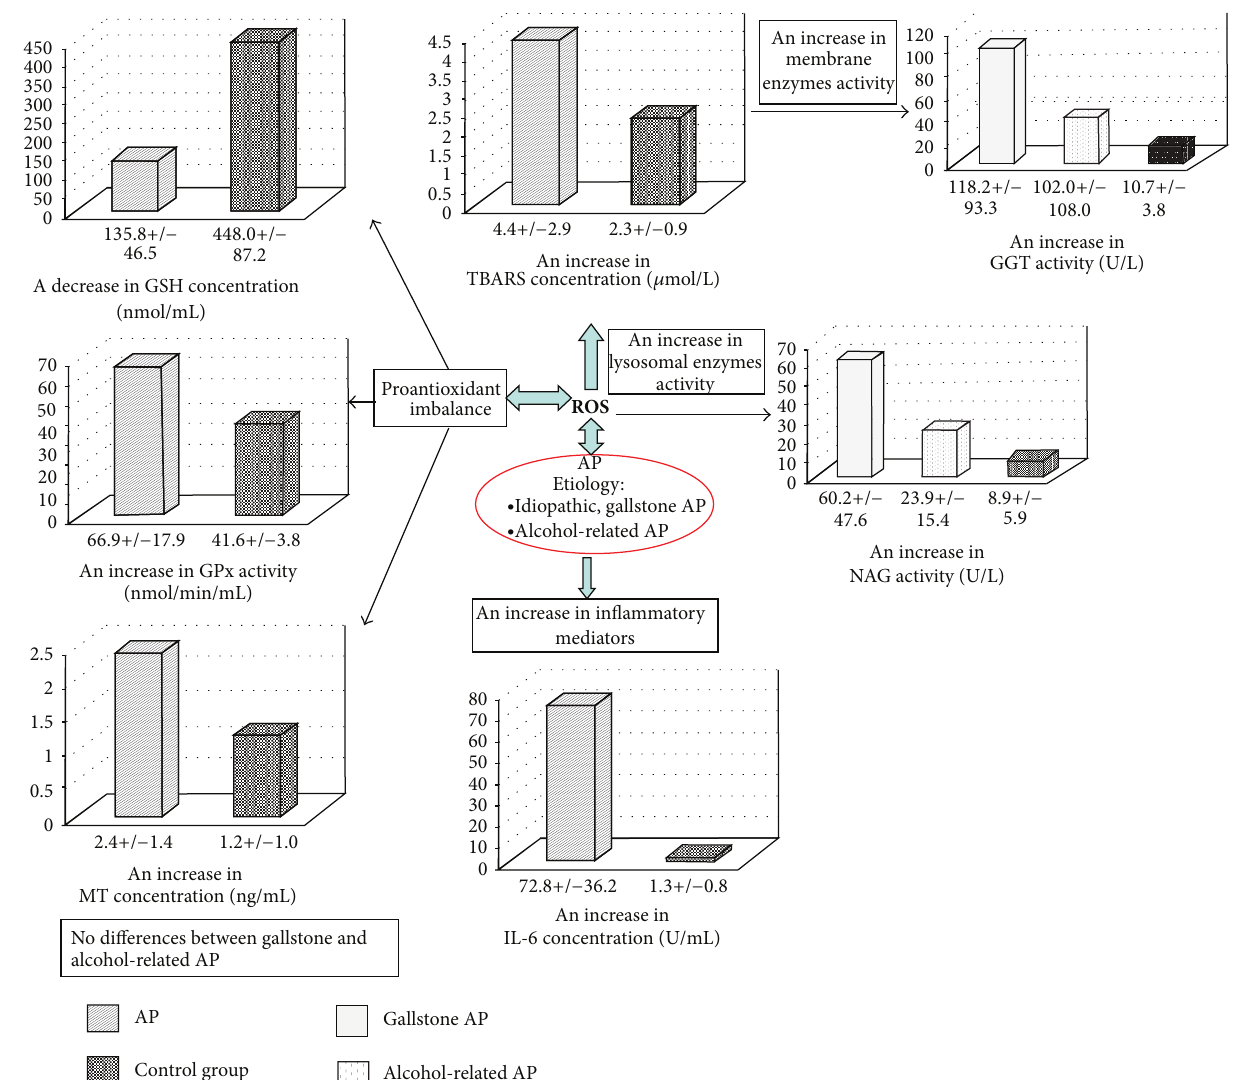
Figure 3: The graphical summary of the most important parameters determinated in the patients with acute pancreatitis compared to control